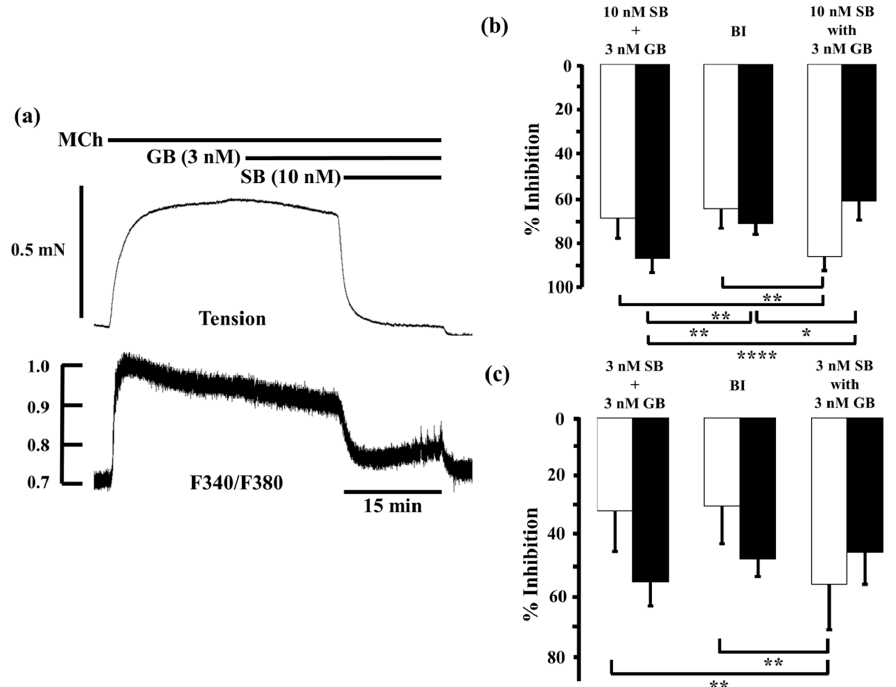
Figure 5. Effects of salbutamol and glycopyrronium in combination on tension and intracellular Ca 2+ concentration induced by muscarinic activation. ( a ) Typical sample record of tension ( upper side ) and F340/F380 ( lower side ) showing the inhibitory effect of salbutamol (10 nM) in the presence of glycopyrronium (3 nM) against 1 μ M MCh-induced contraction; ( b , c ) Percent inhibition of tension (white columns) and F340/F380 (black columns) in 1 μ M MCh-precontracted tissue incubated with 3 nM salbutamol ( b ) and 10 nM salbutamol ( c ) in the presence of glycopyrronium (3 nM). Left , sum of percent inhibition of tension and F340/F380 by the two agents; Center , expected percent inhibition of tension and F340/F380 calculated by the Bliss independence theory; Right , percent inhibition of tension and F340/F380 with the two agents in combination. SB, salbutamol; GB, glycopyrronium bromide; MCh, methacholine; BI, Bliss independence. **** p < 0.0001; ** p < 0.01; * p < 0.05.